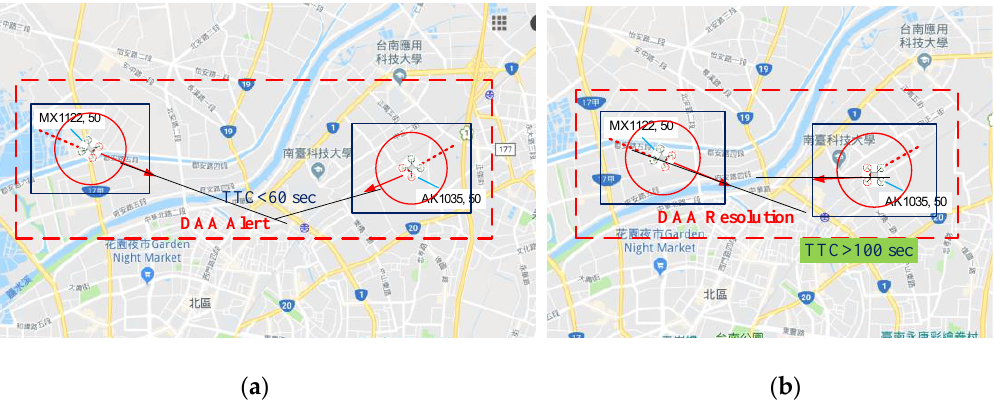
Figure 9. Conflict alert and resolution, less priority UAV avoids ( a ) TTC < 60sec with DAA alert; ( b ) TTC > 100 s with DAA resolution.